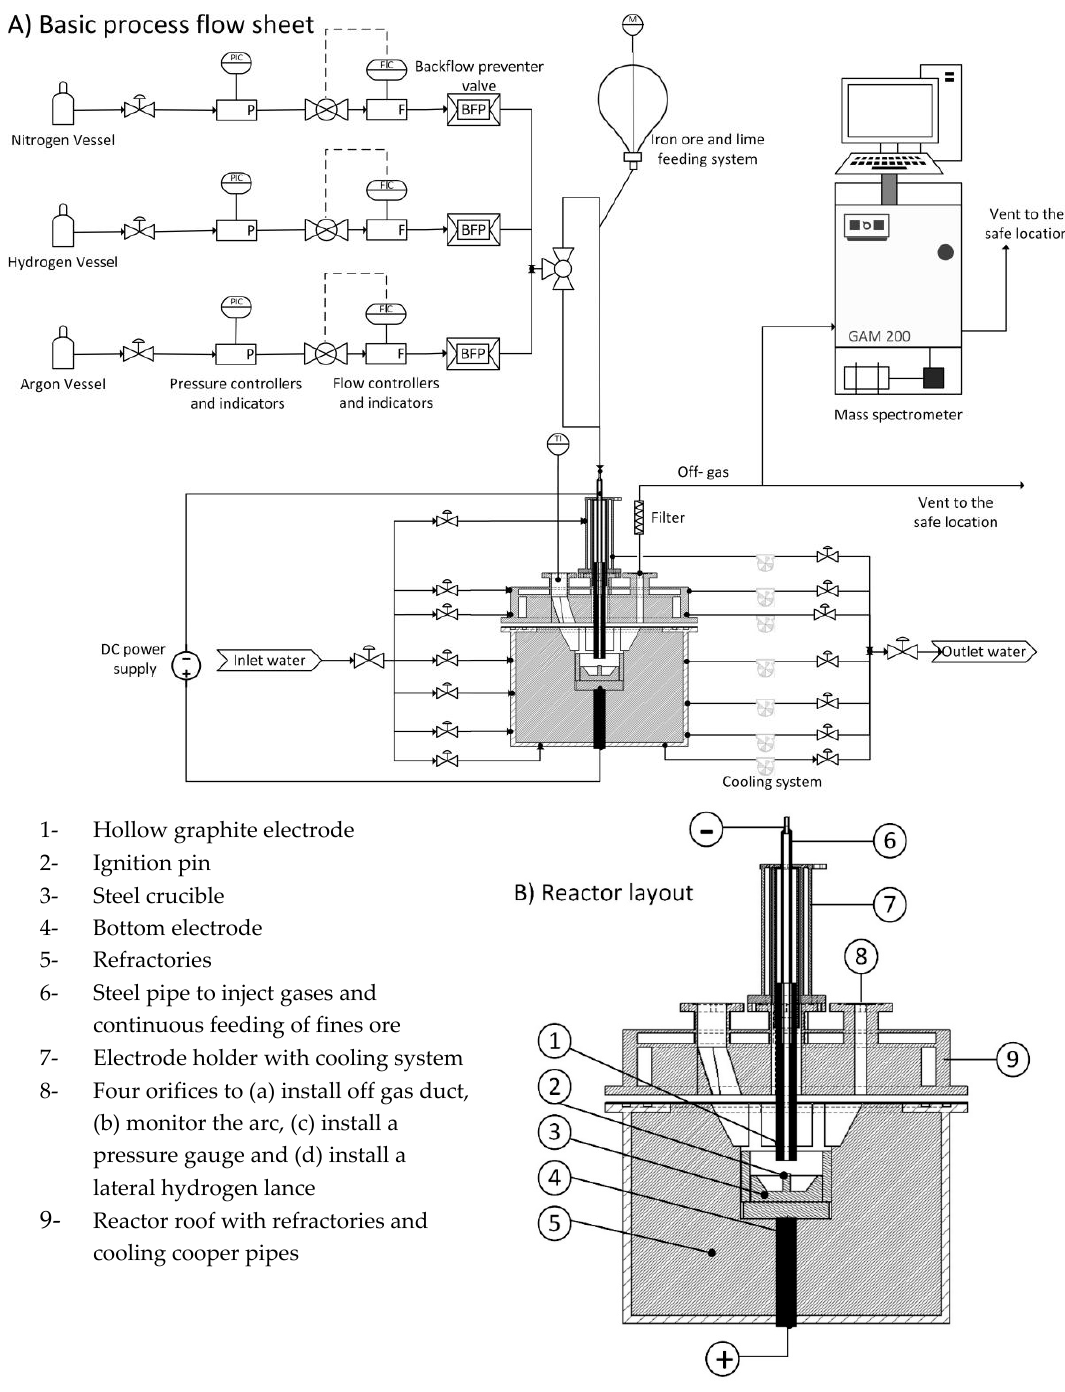
Figure 1. ( A ) A basic process flow sheet of the laboratory-scale plasma facility at Montanuniversitaet Leoben and ( B ) rector layout with the main components.